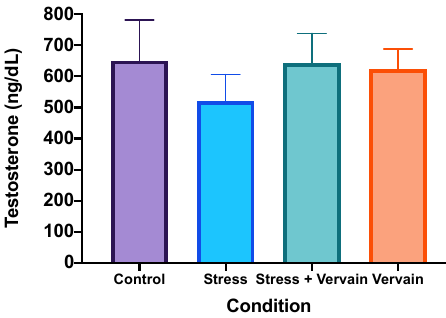
Figure 5. Testosterone levels in testis homogenates.